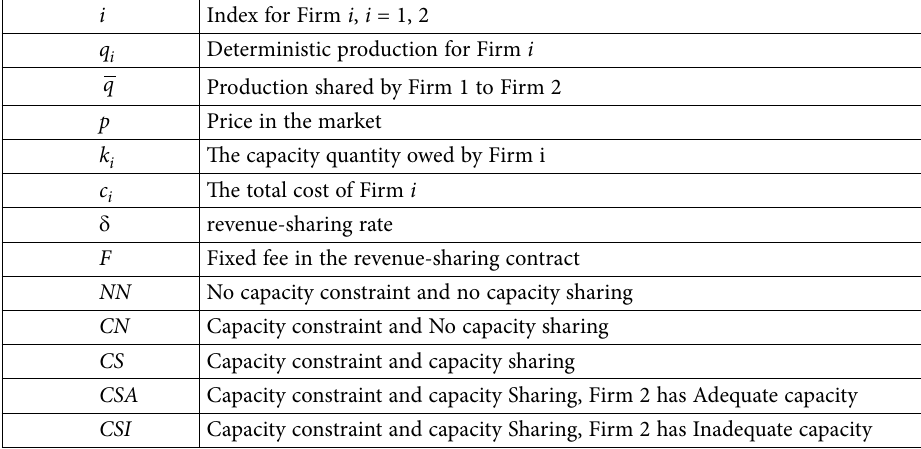
Table 1. The notation used in the